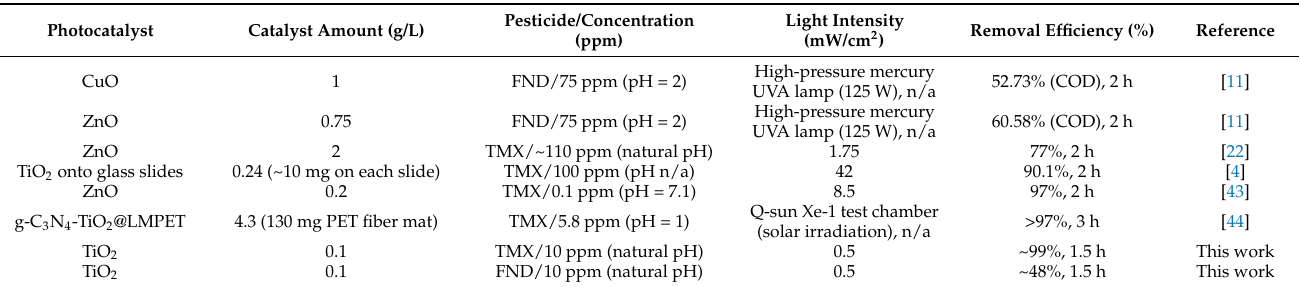
Table 2. Photocatalytic performance of Degussa P25 TiO 2 photocatalyst against TMX and FND compared to other photocatalysts reported in